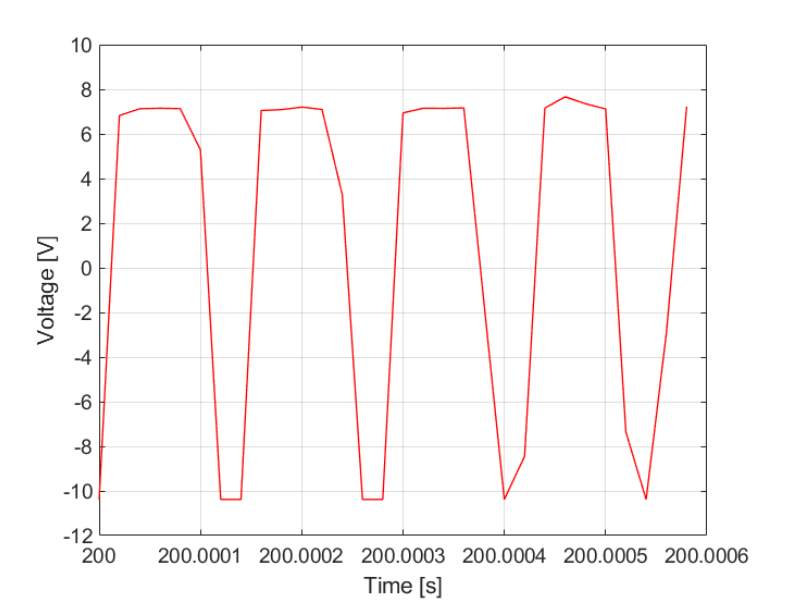
Figure 5. The vibration characteristics of the SAS system. The signal was divided into fragments corresponding to given beam loads, which were then used to determine the frequency